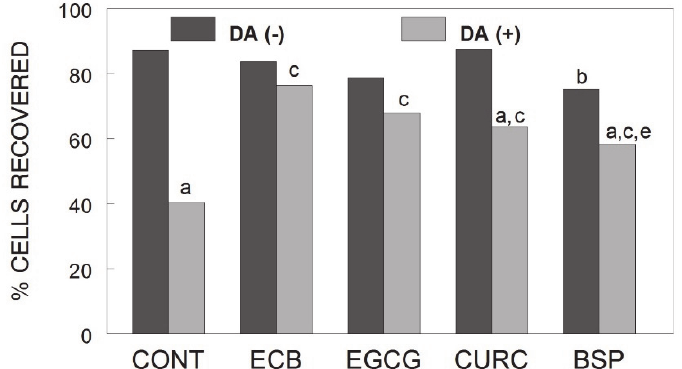
Figure 1. Calcium recovery in E18 rat hippocampal neurons pre-treated with ECB or its component phytochemicals (EGCG, CURC, BSP) and stimulated for 2 h with DA (0.0 or 0.1 mM). Data are expressed as the percentage of cells that return to baseline calcium levels. a = p < 0.05 vs. non-DA-treated cells matched for each treatment; b = p < 0.05 vs. non-DA-treated control cells; c = p < 0.05 vs. DA-treated control cells; e = p < 0.05 vs. DA-treated ECB cells; Mann–Whitney U post-hoc. DA = dopamine; CONT = control; ECB = combination compound; EGCG = epigallocatechin gallate; CURC = curcumin; BSP = broccoli sprouts.